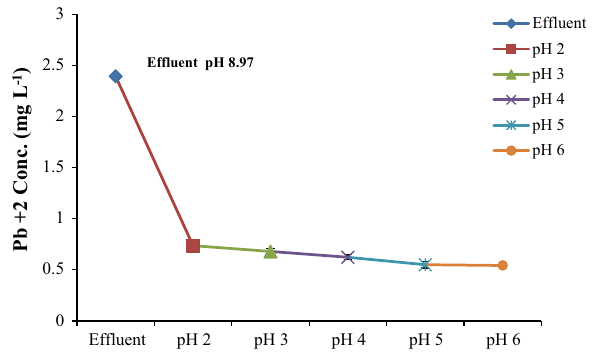
Fig. 5 Effect of different pHs on the concentration of Pb 2+ in battery manufacturing industry effluent after adsorption at room temperature (25 ± 3 °C) and optimized pH 5, adsorbent dose 5.0 g l −1 and contact time of 140 min (SD shown by error bars)